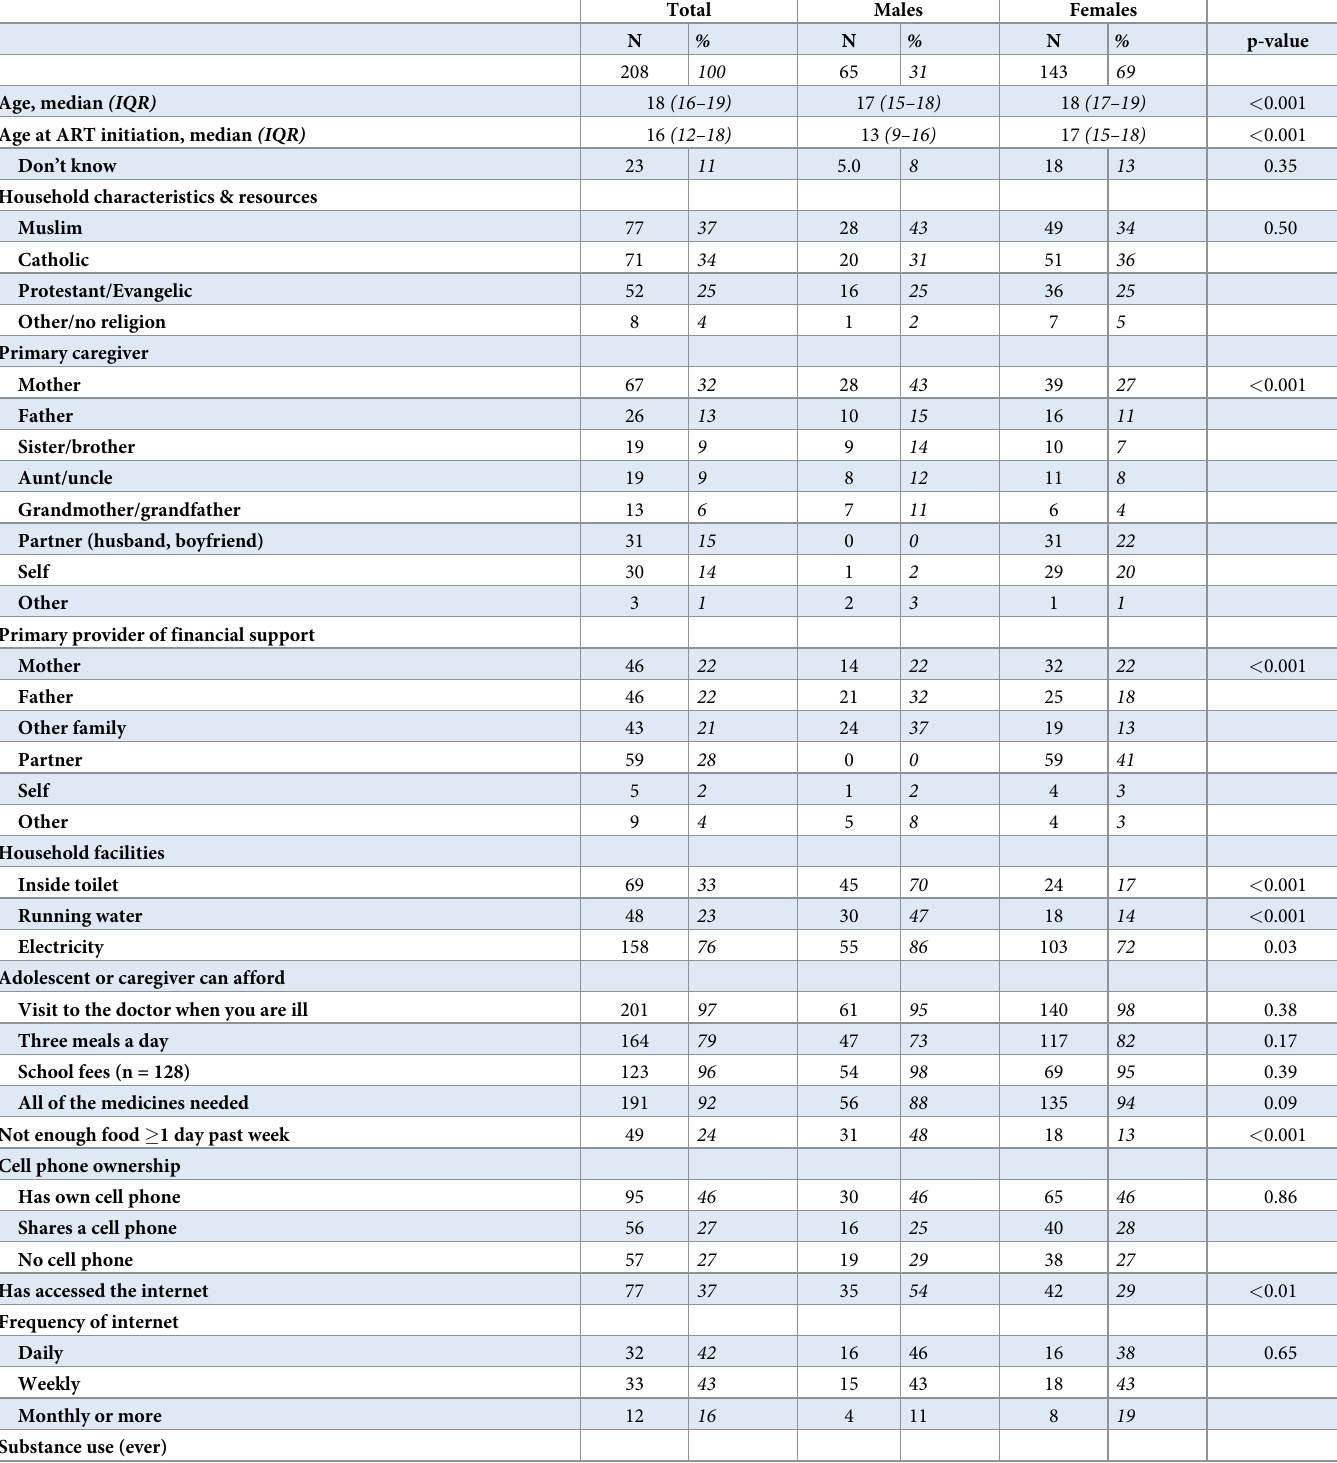
Table 1. Demographic characteristics of adolescents living with HIV 15–19 years of age enrolled in care at three health facilities in Nampula, Mozambique, 2019 (N =